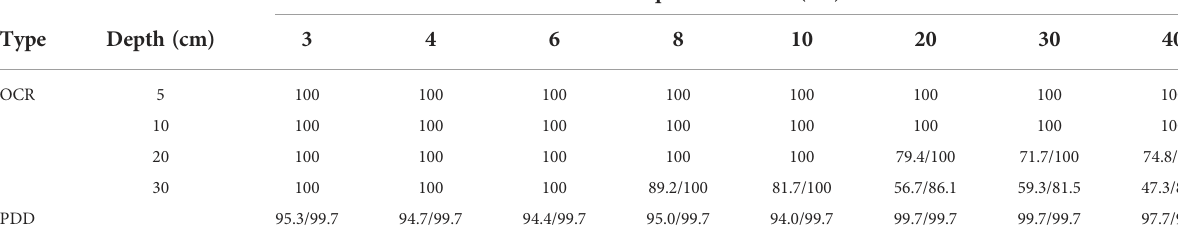
Square fi eld size (cm)